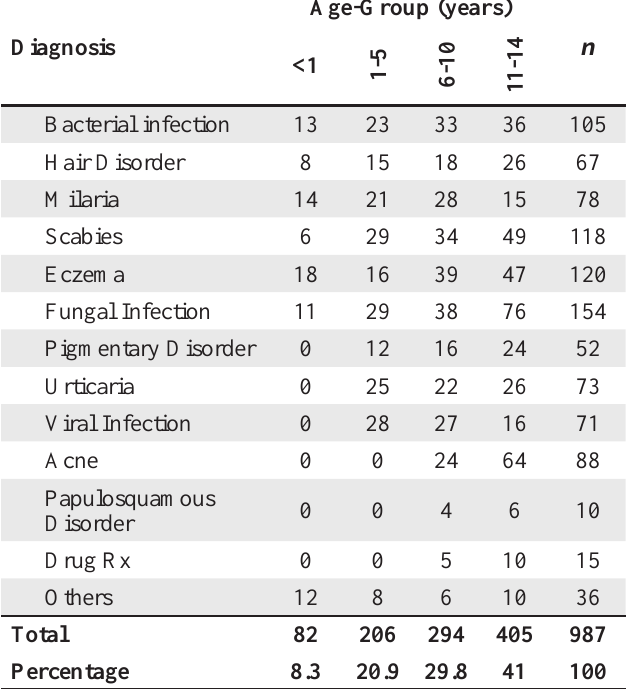
Table 2 : Distribution of dermatoses in different age